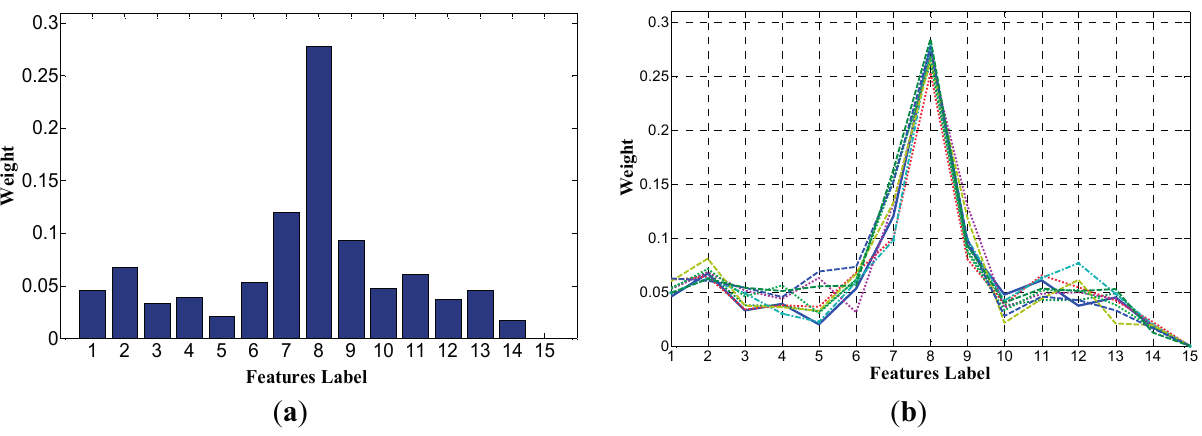
Figure 7. ( a ) The weight distribution of 15 features in one set; ( b ) The weight distribution of 15 features in ten sets.